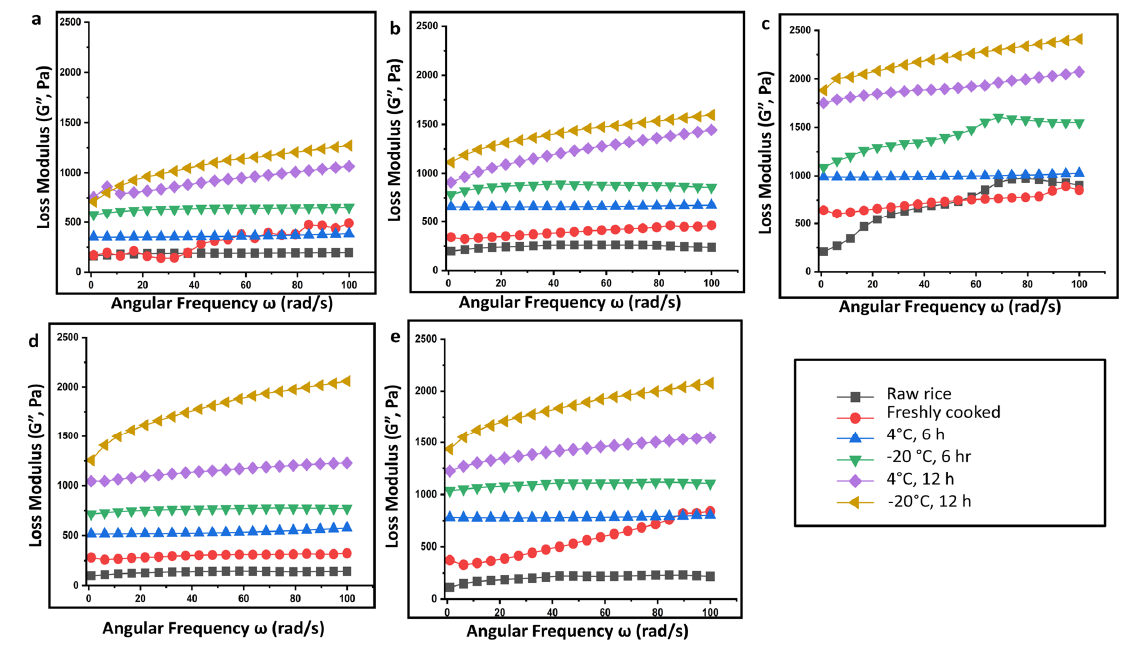
Figure 5. Loss modulus (G”) as a function of the angular frequency of rice samples subjected to different storage conditions for retrogradation: ( a ) Diasang lahi, ( b ) Khaju lahi, ( c ) Dhusuri bao, ( d ) Omkar, and ( e ) Bili rajamudi.